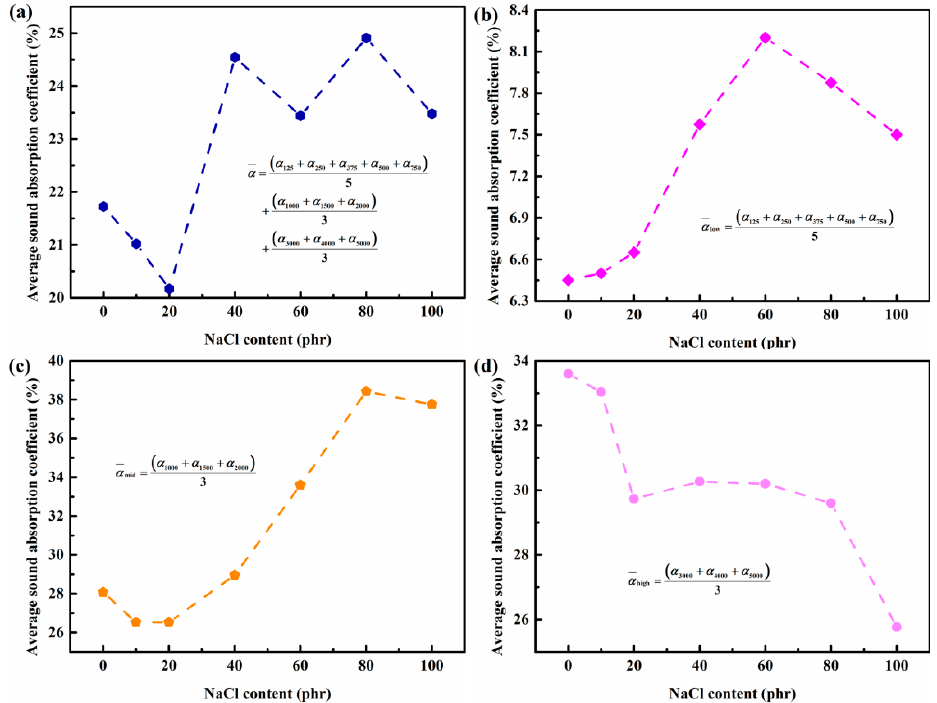
Figure 6. Effect of the addition amount of NaCl on sound absorption coefficient of silicon rubber foams in different frequency ranges. ( a ) 125–5000 Hz; ( b ) 125–750 Hz; ( c ) 1000–3000 Hz; ( d ) 3000–5000 Hz.